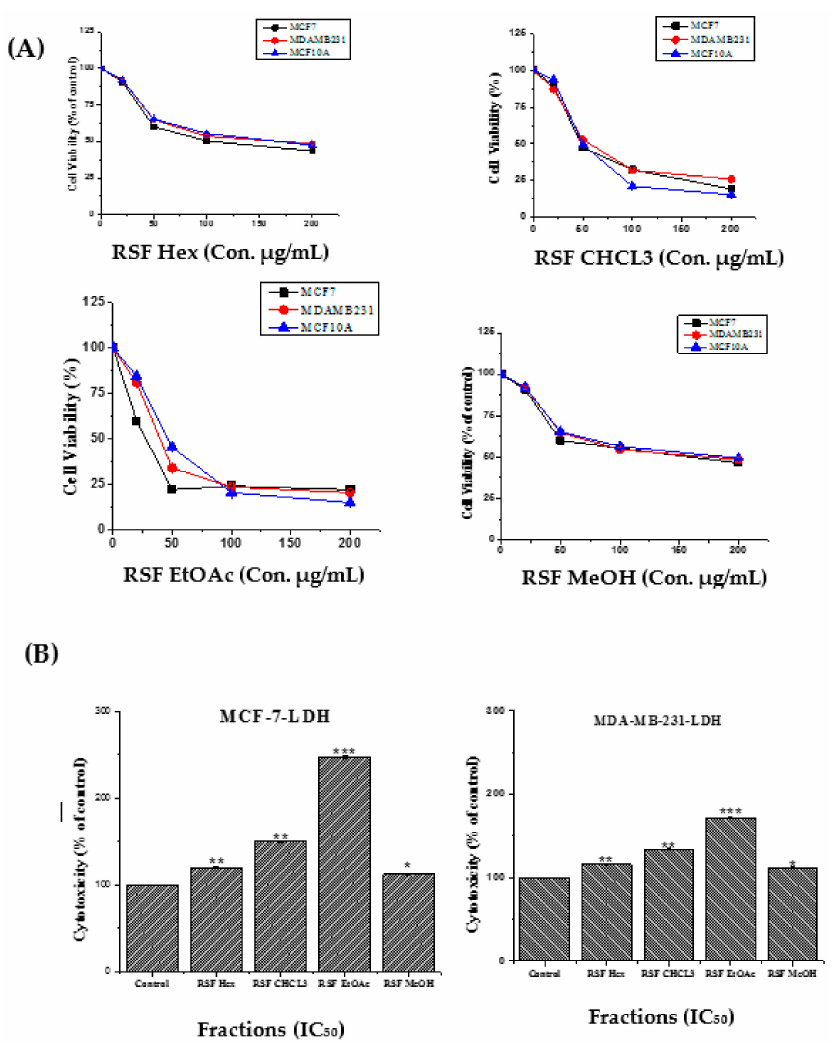
Figure 1. Cytotoxic e ff ects of R. stricta Fruit fractions on human breast cancer cells. ( A ) Dose-dependent curves of di ff erent extract treatments. Cells were cultured in 24-well plates and treated with di ff erent concentrations (10–200 µ g / mL) for 48 h. Cell viability was measured by MTT assay. ( B ) MCF-7, MDA-MB-231 and MCF-10A were treated at IC 50 for 48h. LDH released into media was determined at 490 nm using a microplate reader. Statistical di ff erences were analyzed using Student’s t -test. Data are presented as mean ± S.D. (* p < 0.05, ** p < 0.01, *** p < 0.001 was considered significant